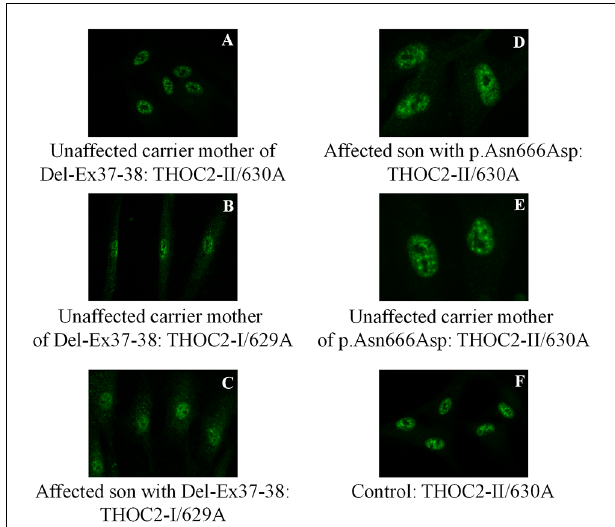
FIGURE 6 | THOC2 localization is unaltered in variant fibroblasts. THOC2-II antibody detects THOC2 protein in fibroblasts of the Del-Ex37 - 38 unaffected carrier mother (A) but not affected son (not shown, as we detected no fluorescence signal). However, the THOC2-I antibody detects THOC2 protein in fibroblasts of unaffected carrier mother (B) and the affected son with Del-Ex37-38 (C) . Localization p.Asn666Asp THOC2 protein in fibroblasts of an affected son (D) , his unaffected carrier mother (E) and control (F) .